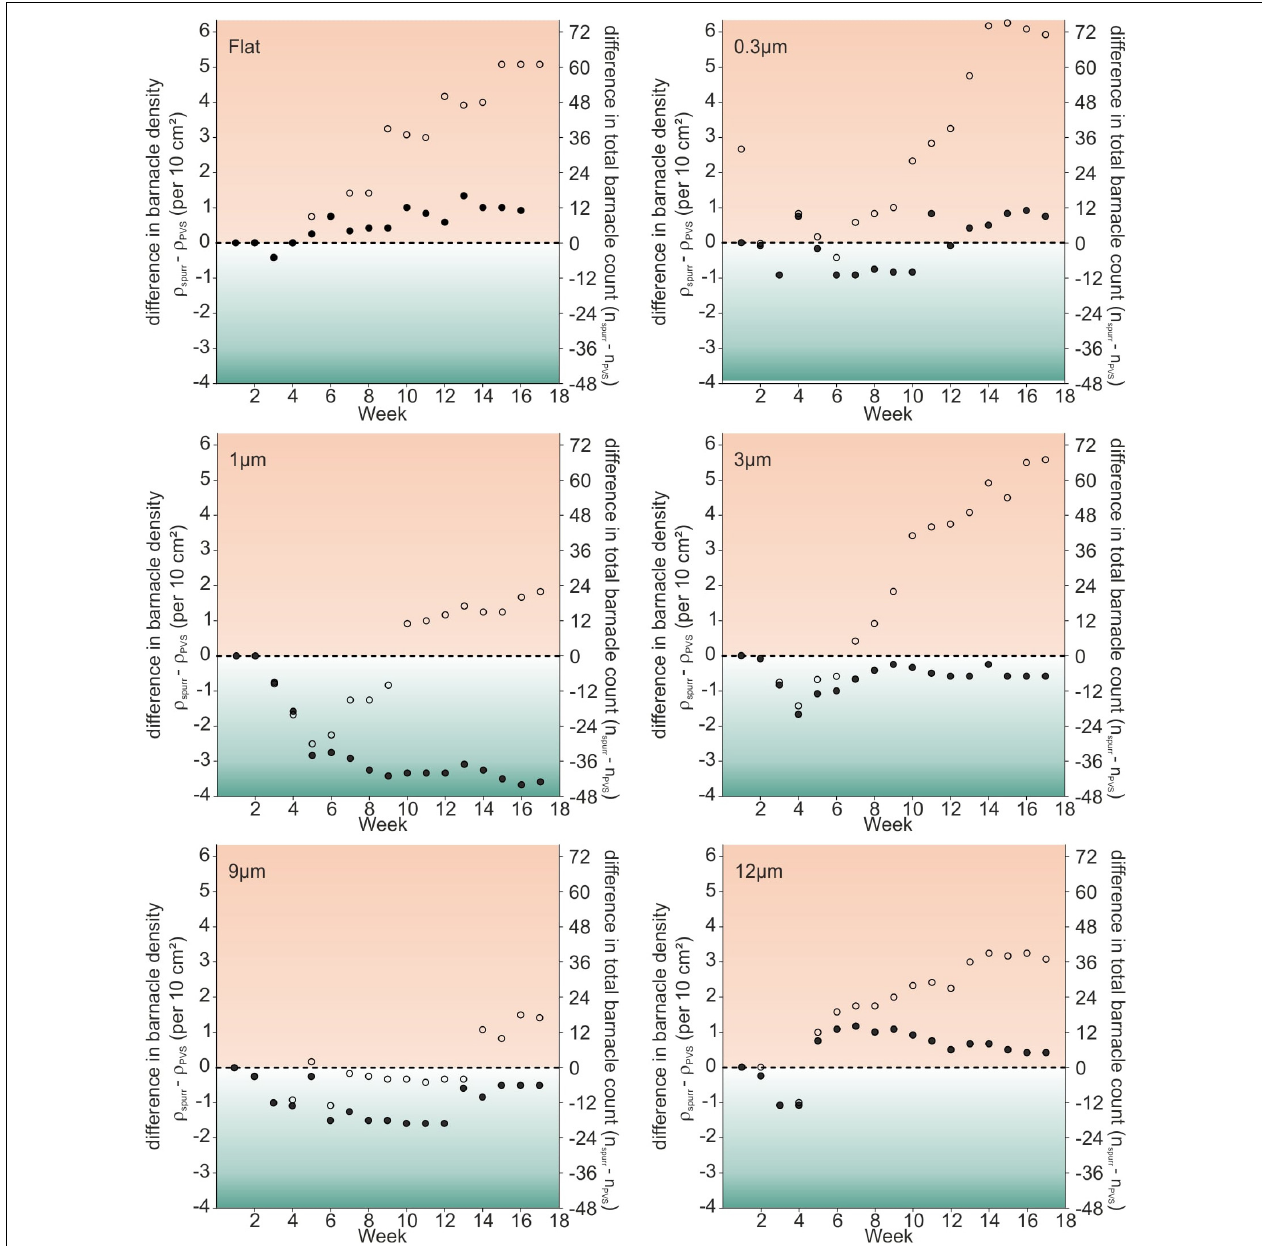
FIGURE 5 | Dot plots showing the difference in barnacle densities (total number of barnacles per 10 cm 2 ) between substrates made of Epoxy and PVS for each roughness sample during the field experiment 1. Empty circles represent the difference between actual barnacle densities on Epoxy and PVS types of samples. Filled circles represent the difference between the cumulative barnacle density on Epoxy type of samples and the cumulative barnacle density on PVS type of